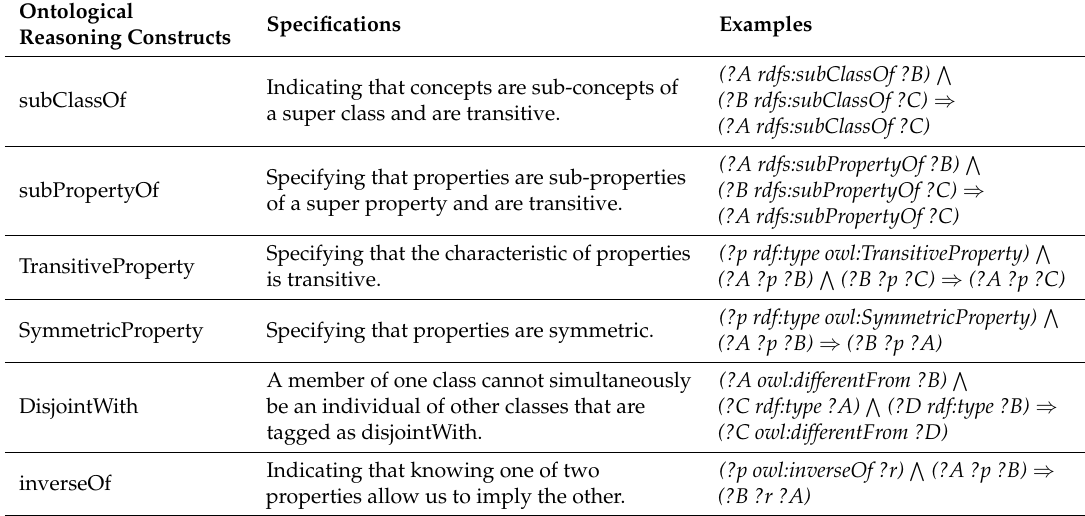
Table 1. Partial ontological reasoning